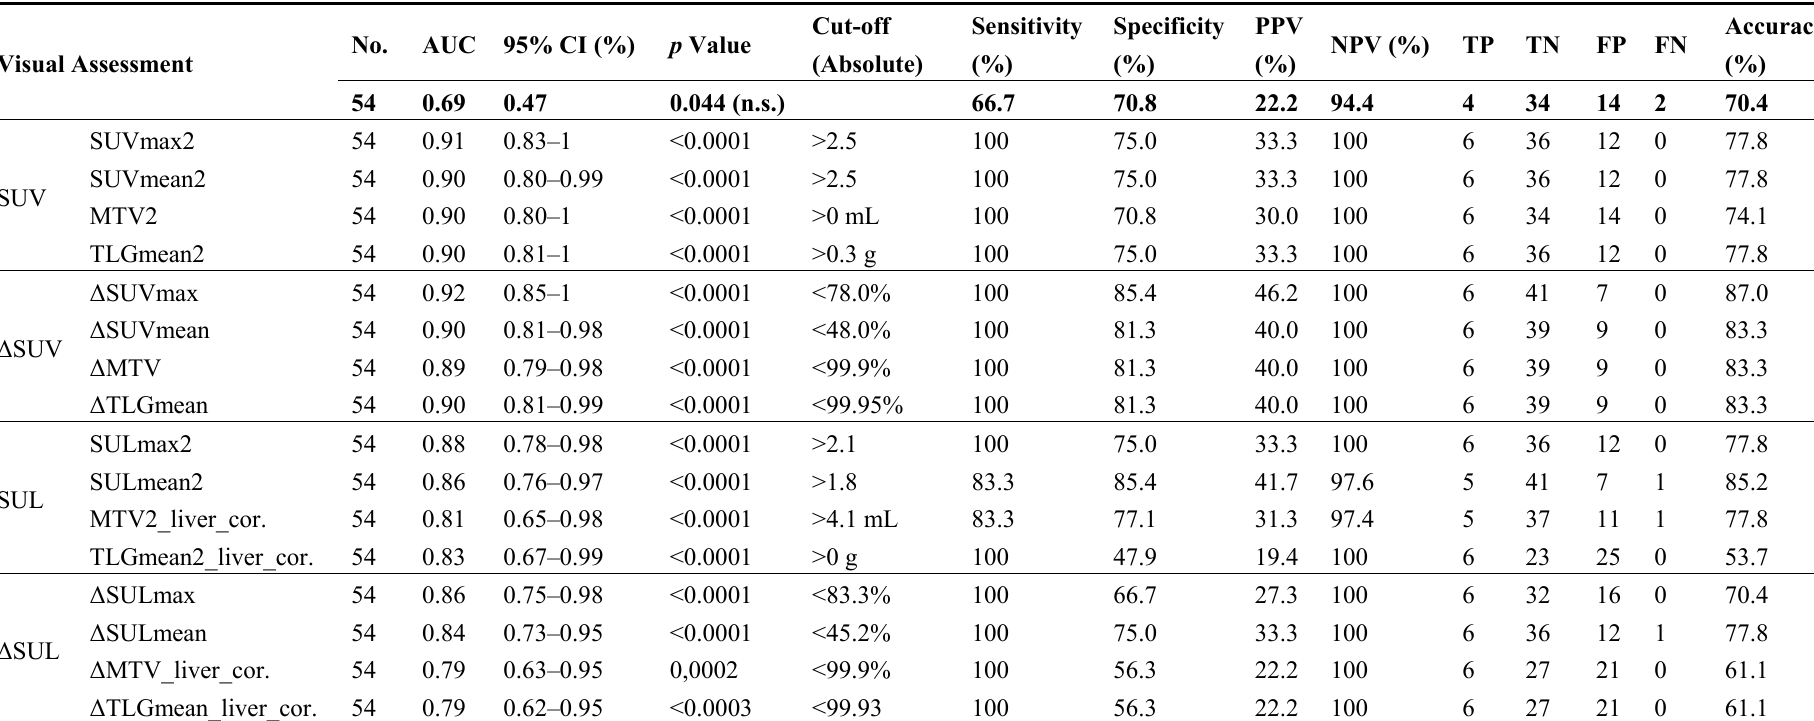
Table 2. Single time point analyses and Inter-time point analyses comparing relative differences between PET1 and PET2: Results for response prediction at interim PET (PET2) and Δ-analyses using receiver operating